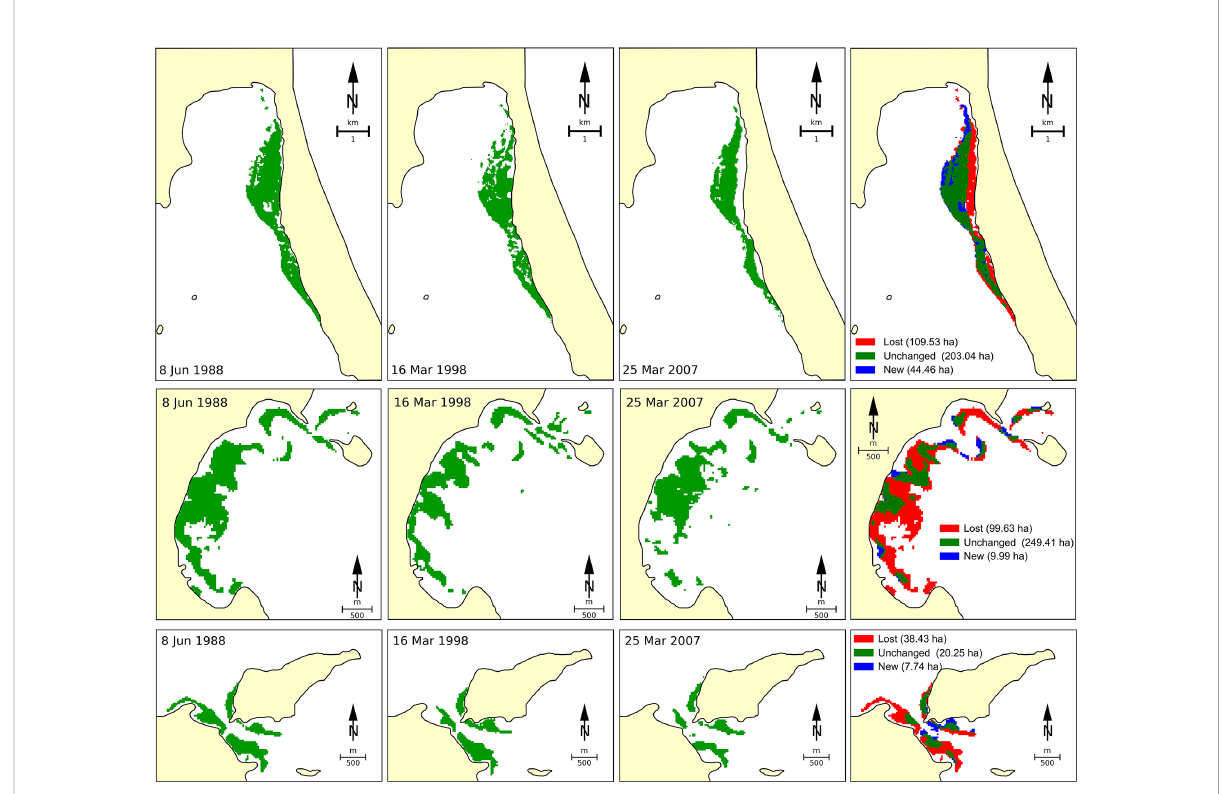
FIGURE 2 Changes of seagrass beds at three sites of Van Phong Bay (region 3) from 1998 to 2018 deduced by using datasets of satellite image Landsat 5 TM and Landsat 8 OLI. The fi gure was adapted from Vo et al.